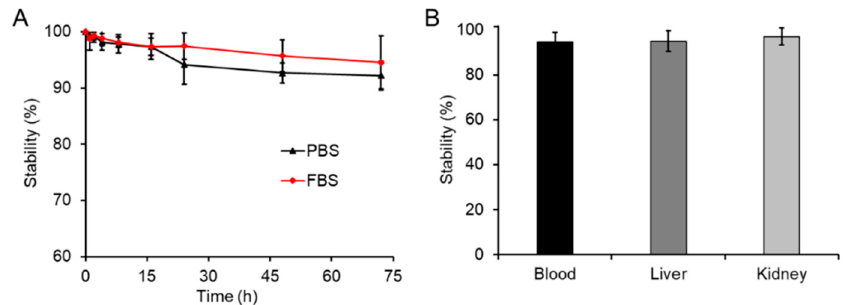
Figure 3. In vitro stability studies of the radioimmunoconjugate 64 Cu-PCB-hnRNP in PBS and FBS ( n = 3) at various time points ( A ). In vivo stability studies of radioimmunoconjugate 64 Cu-PCB-hnRNP in the blood, liver, and kidneys of BALB/c mice ( n = 3) 1 h p.i. ( B ).